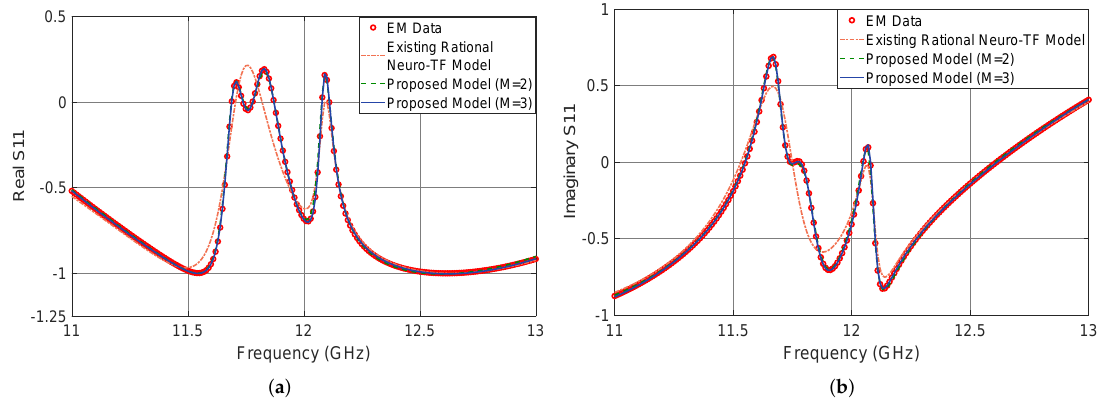
Figure 6. Comparison of Re ( S 11 ) and Im ( S 11 ) for different modeling approaches and EM data at test sample x = [ 14.56 15.20 8.63 6.17 ] T (mm) for the three-order waveguide filter example. ( a ) Re ( S 11 ) and ( b ) Im ( S 11 ) .